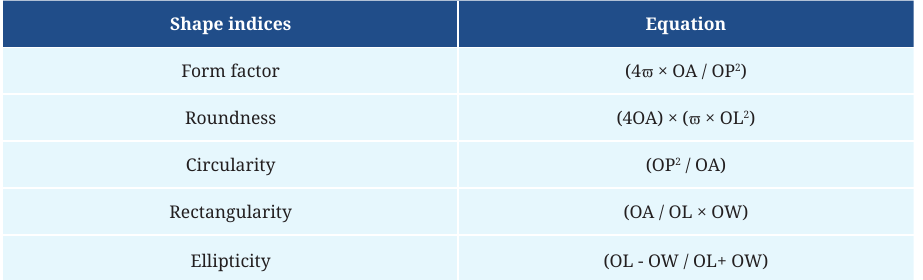
TABLE 1 | Shape indices of otoliths calculated from morphometric measurements. OA: otolith